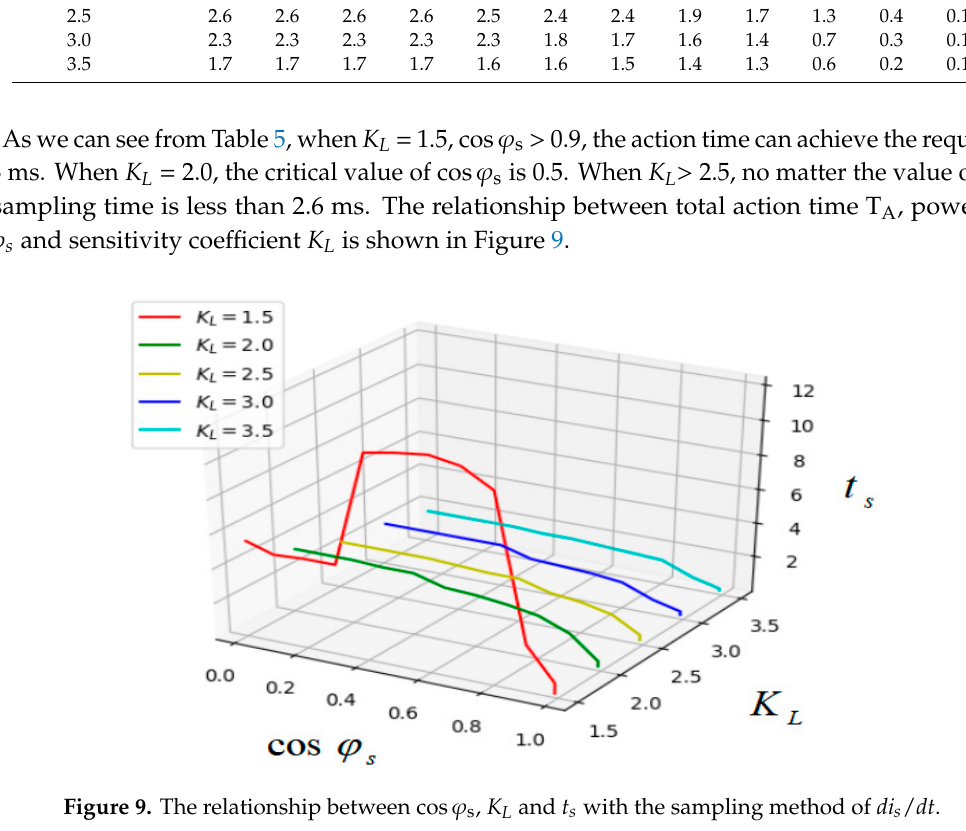
ϕ cos , L K and s t with the sampling method of dtdi s / s